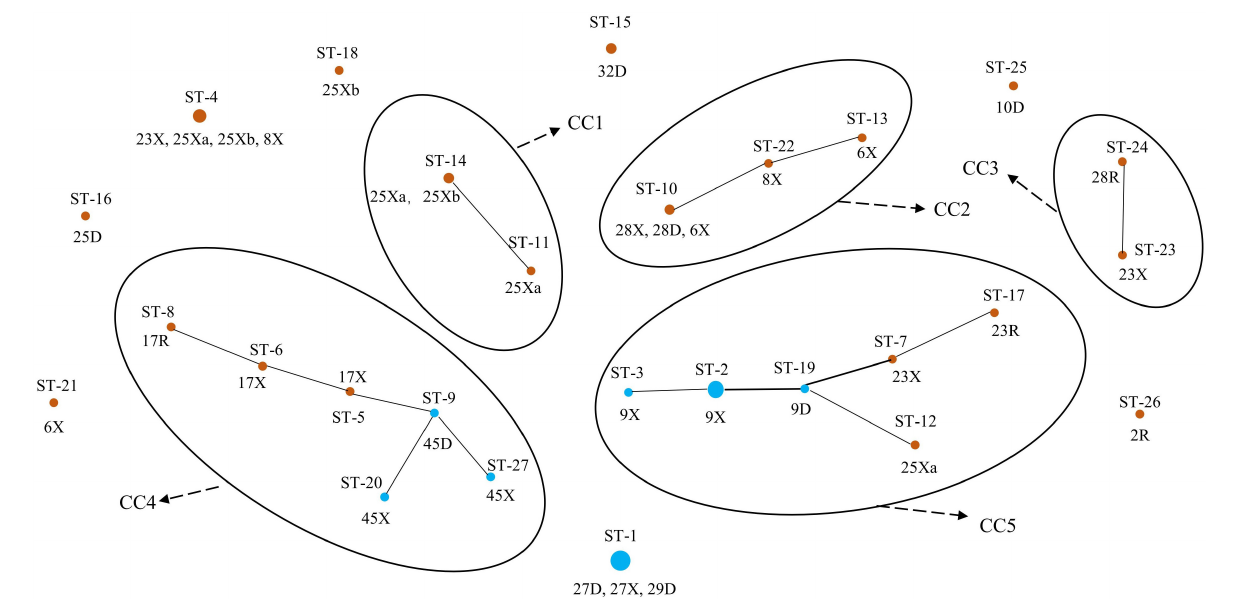
FIGURE 3 | Population structure of 64 representative L . paracasei strains by goeBURST. Brown represents the Uighur; blue represents the